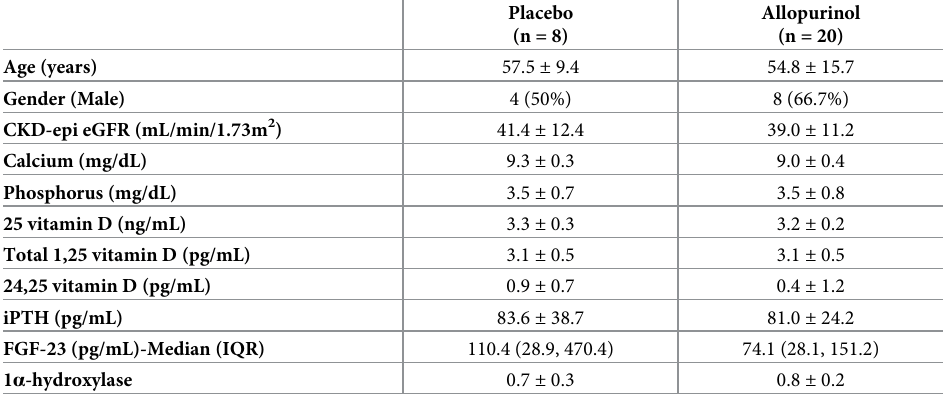
Table 3. Baseline characteristics of the subset of subjects with 1 α -hydroxylase protein expression according to study